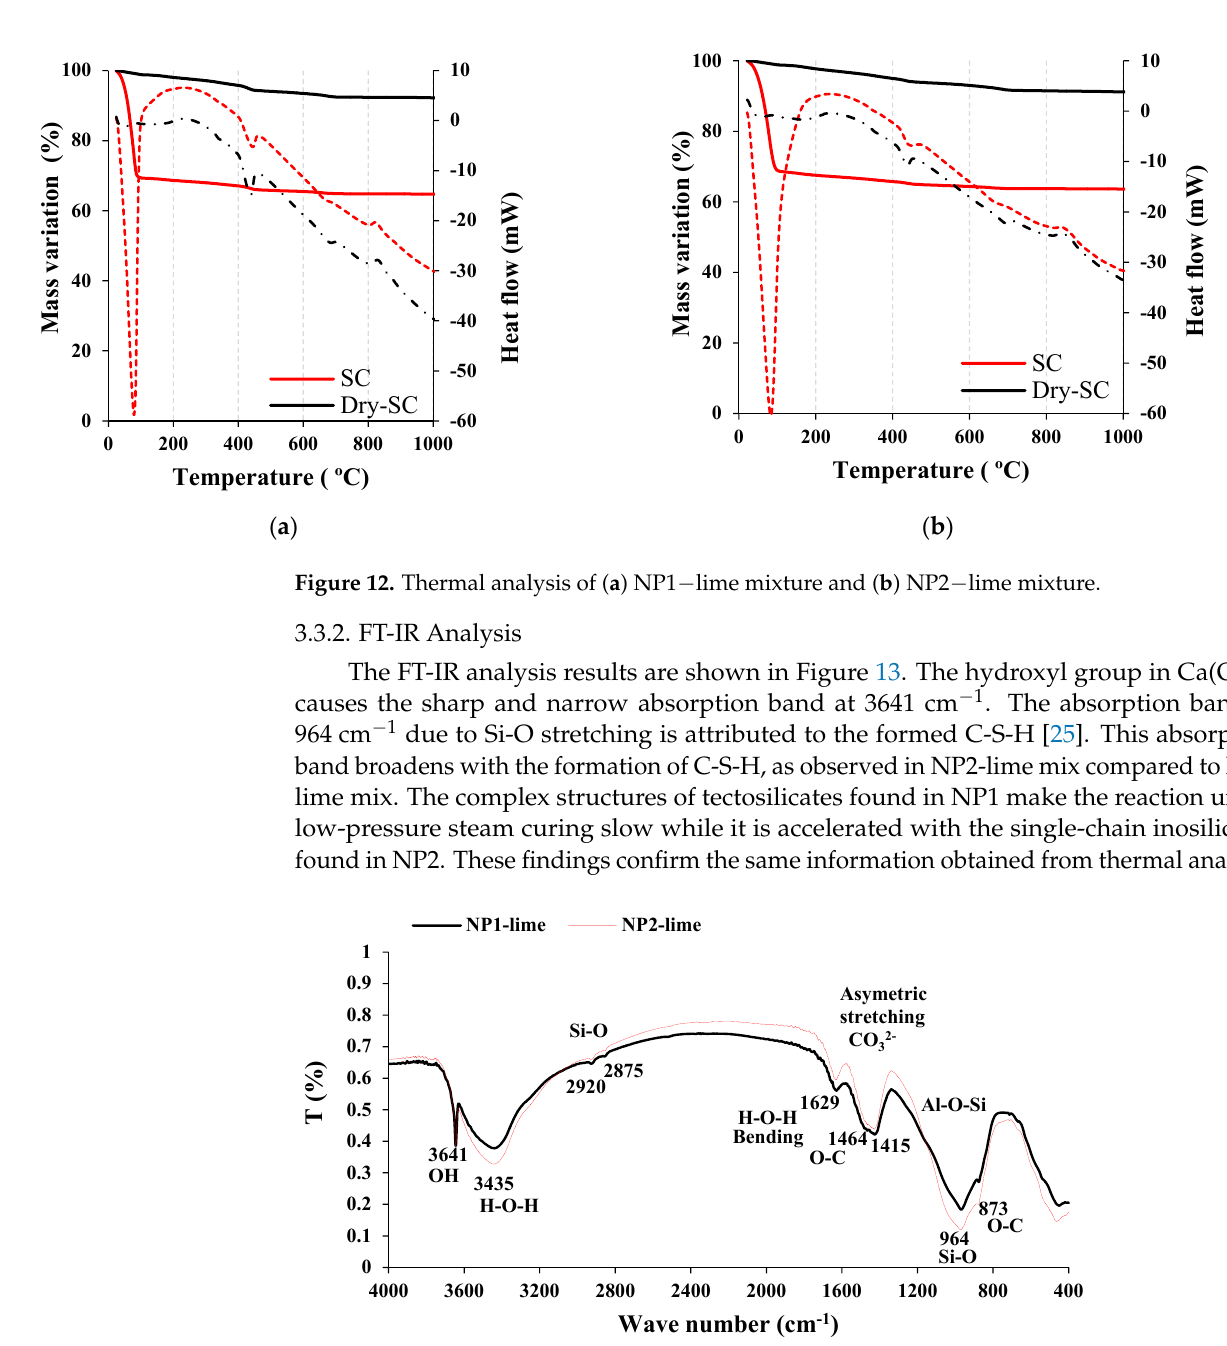
Figure 13. FT − IR spectrum for NP1 − lime and NP2 − lime mixes.